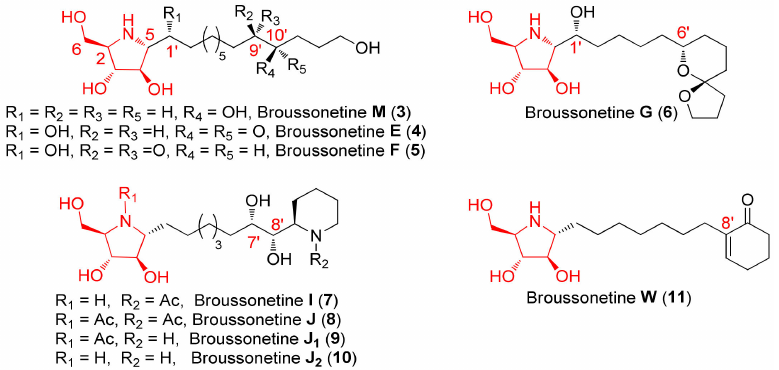
Figure 2. Some representative